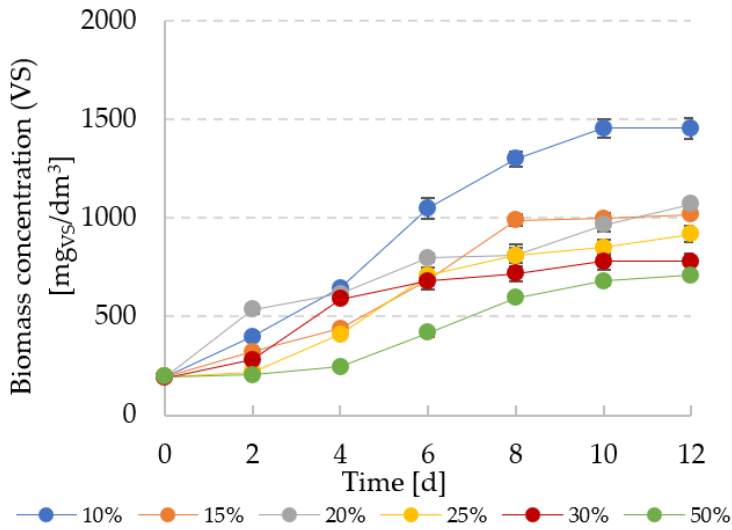
Figure 2. Dynamics of microalgal biomass growth.